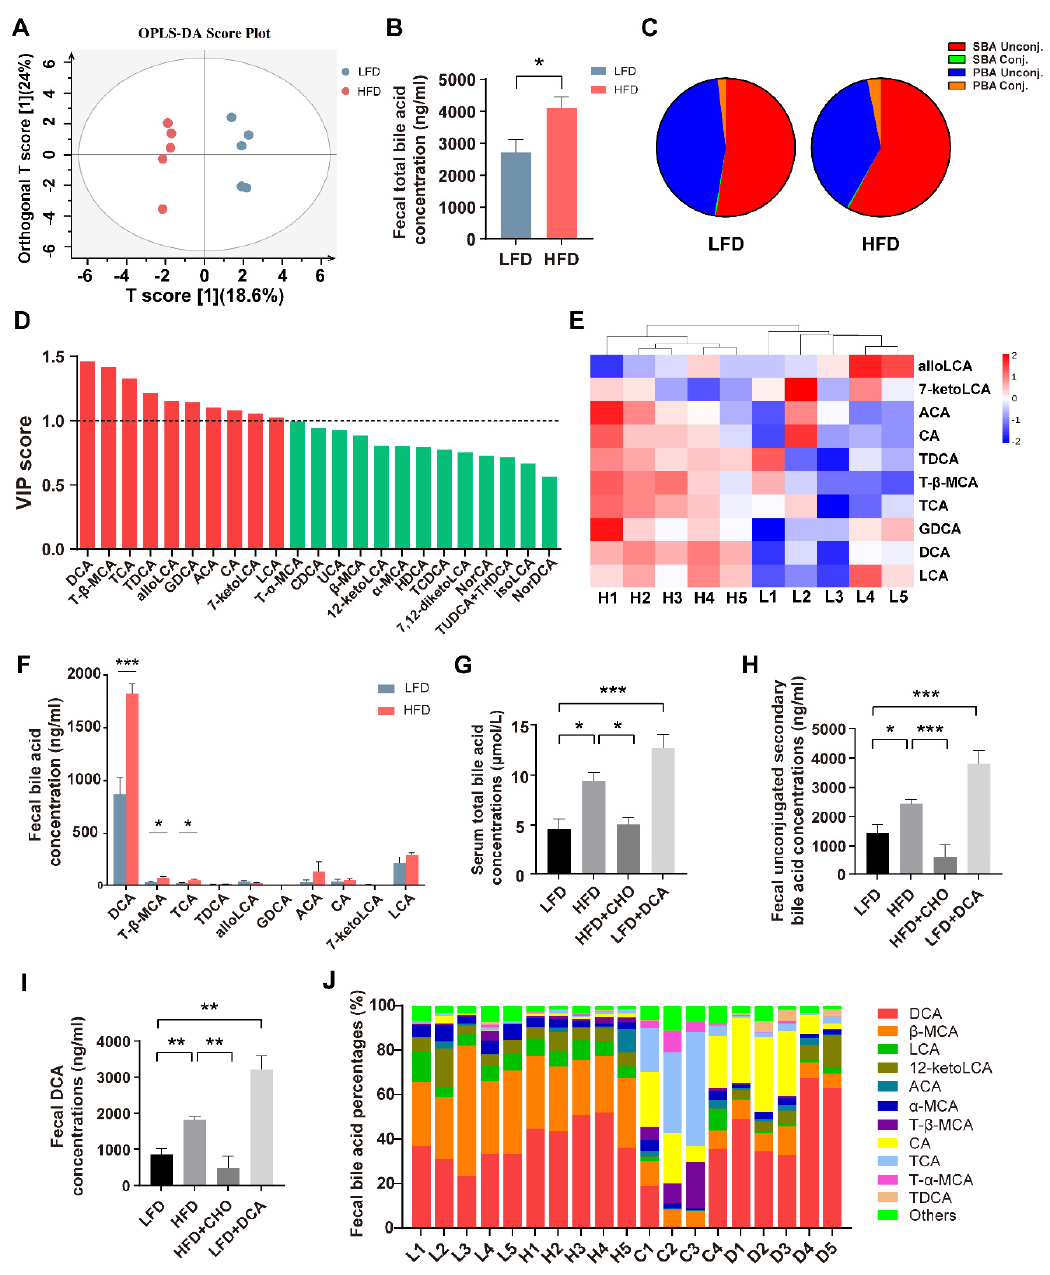
Figure 1. High-fat feeding induces disorder of the bile acid pool and increases DCA levels. ( A ) Orthogonal partial least squares discriminant analysis (OPLS-DA) of faeces in the LFD and HFD groups. R2Y = 0.983, Q2 = 0.647. ( B – E ) Comparison of faecal bile acids in total bile acid concentrations ( B ), the bile acid composition ratio ( C ), variable importance of projection (VIP) value (red bars: VIP > 1) ( D ), heat map of bile acids with VIP > 1 ( E ), and individual bile acid concentrations ( F ) in the LFD and HFD groups (n = 5). ( G ) Serum total bile acid concentrations in the LFD, HFD, HFD + CHO, and LFD + DCA groups (n = 5). ( H – J ) Faecal bile acid in secondary unconjugated bile acid concentrations ( H ), DCA concentrations ( I ), and the bile acid composition ratio ( J ) in the LFD, HFD, HFD + CHO, and LFD + DCA groups (n = 4–5). Data are shown as the mean ± SEM. Unconj., unconjugated; Conj., conjugated; LFD, low-fat diet; HFD, high-fat diet; DCA, deoxycholic acid; CHO, cholestyramine; L, LFD; H, HFD; C, HFD + cholestyramine; D, LFD + deoxycholic acid. * p < 0.05; ** p < 0.01; *** p <